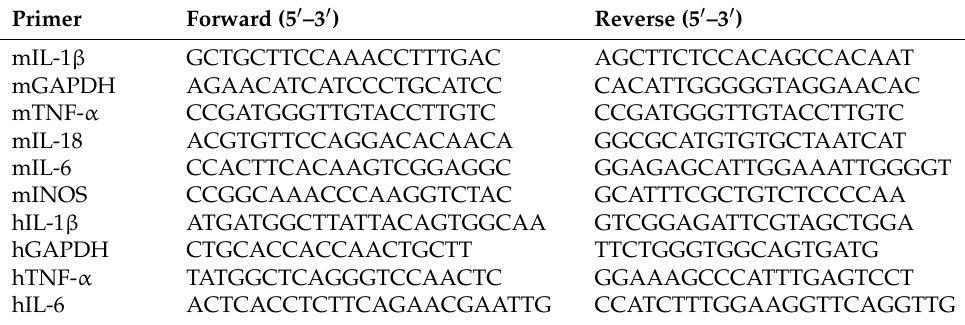
Table 2. The primers for